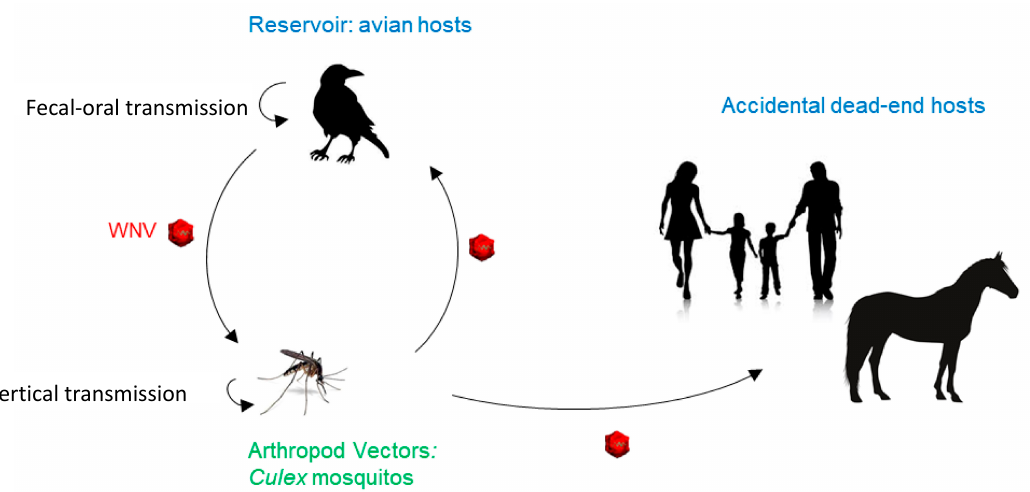
Figure 1. West Nile virus (WNV) transmission cycle. In nature, WNV transmission occurs through an enzootic cycle between birds and mosquitoes, the latter mainly of the genus Culex . Humans and mammals can be infected but are considered to be dead-end hosts.